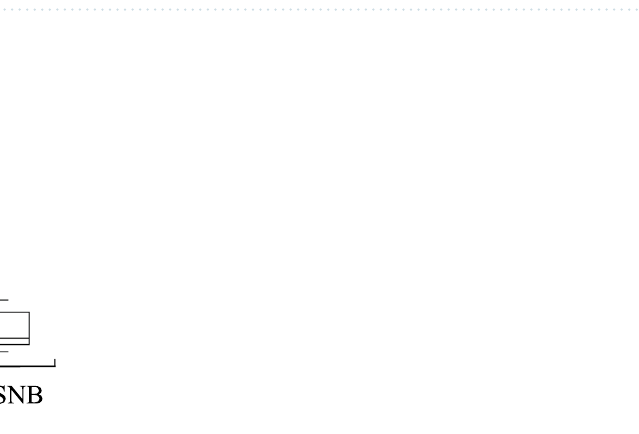
Figure 8. Comparison of sum of normalised power of peripheral arterial stiffness β at low frequency range LF before and after sympathetic nerve block by